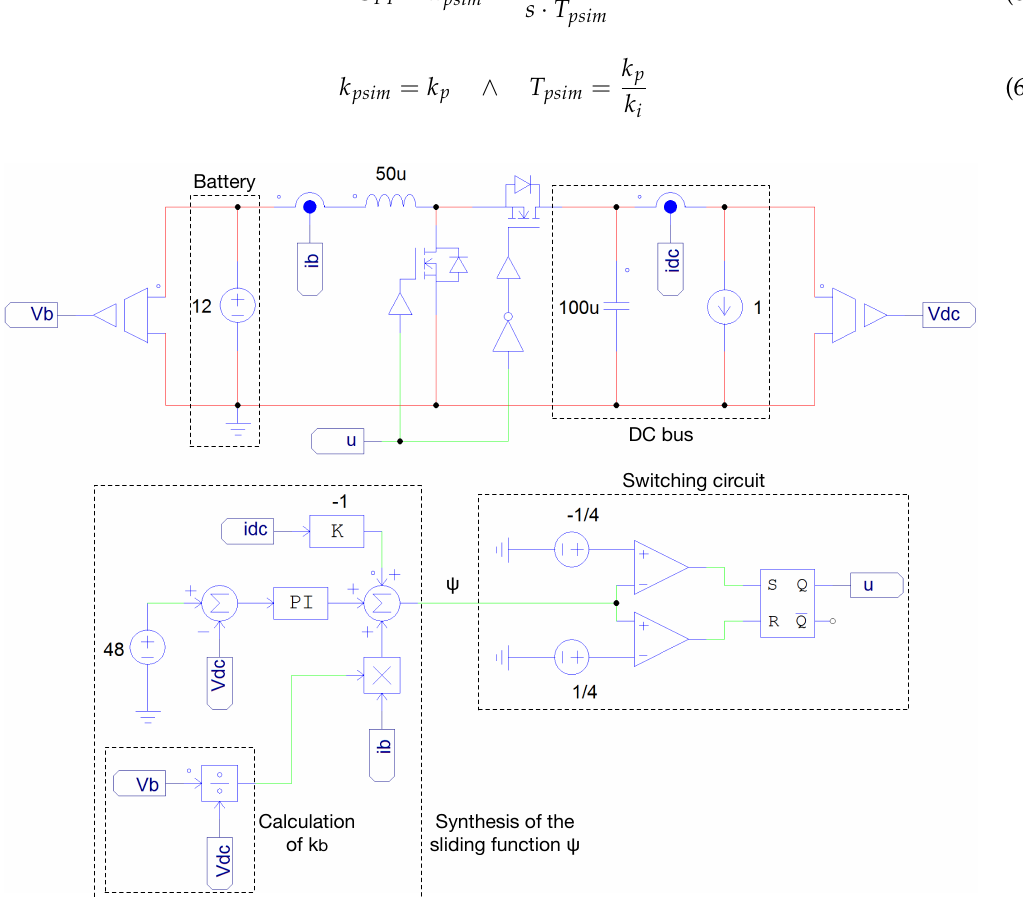
Figure 14. Circuit implemented in PSIM electrical